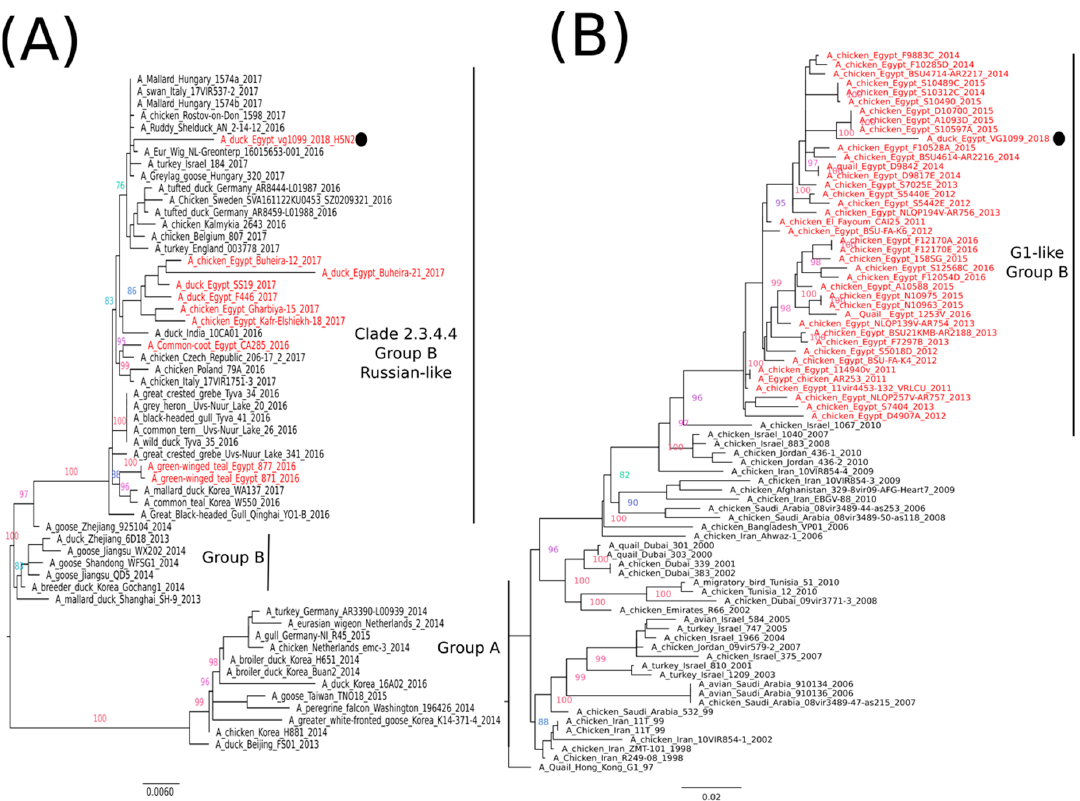
Figure 1. Phylogenetic trees of the nucleotide sequences of the HA ( A ) and NA ( B ) gene segments. Maximum likelihood calculations were done using the IQTree software under the best fit model according to the Bayesian criterion. Egyptian H5N2 virus is indicated with a black dot. ( C ) Emergence and possible reassortment option of the novel HPAI H5N2 virus found in Egypt in 2018. Phylogenetic analysis of the HA gene segment showed that the EG-VG1099 virus was closely related to HPAI H5N8 viruses reported in Europe during 2016–2017 (2.3.4.4 clade, group B), and phylogenetically distinguished from the previously reported HPAI H5N8 viruses in Egypt (Figure 1A). The NA gene segment of EG-VG1099 was phylogenetically grouped with the LPAI H9N2 viruses isolated from Egypt (Figure 1B). The remaining six genes (PB2, PB1, PA, NP, M, and NS) of the EG- VG1099 virus were clustered with Egyptian HPAI H5N8 viruses: A/chicken/Egypt/Gharbiya-15/2017